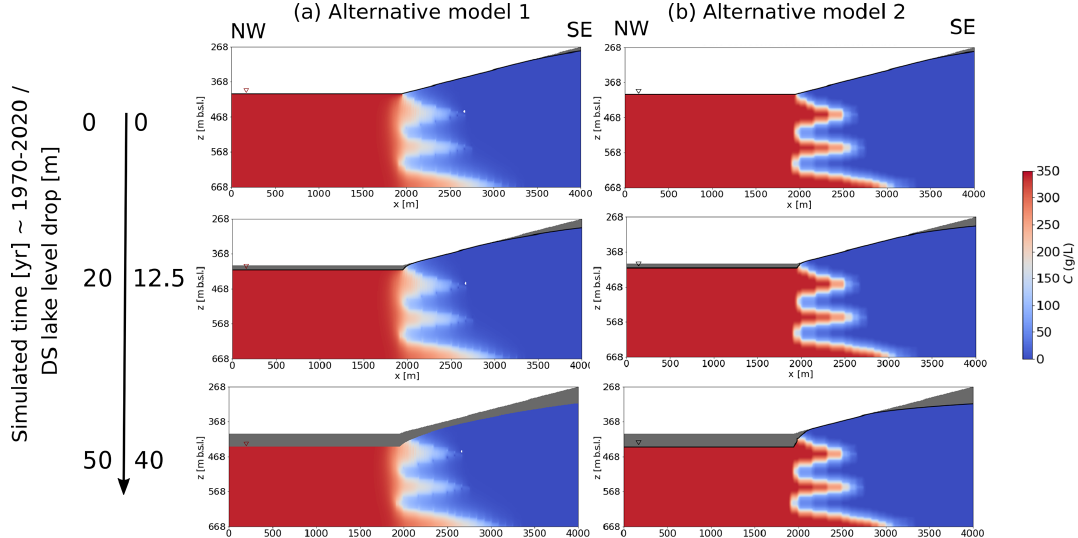
Figure B2. Alternative (deprecated) hydrogeological model results for concentration and water table. (a) Model 1 with horizontal and vertical hydraulic conductivity of LS of the same value as AS ( k h = 1 × 10 − 5 ms − 1 , k v = 1 × 10 − 6 ms − 1 ). This high hydraulic conductivity for mud is unrealistic for the initial aquiclude conditions. (b) Model 2 with horizontal and vertical hydraulic conductivity of LS 4 orders of magnitude the water table behaves in an unrealistic (non-linear) way, and non-convergence and no clear saltwater–freshwater boundary changes are